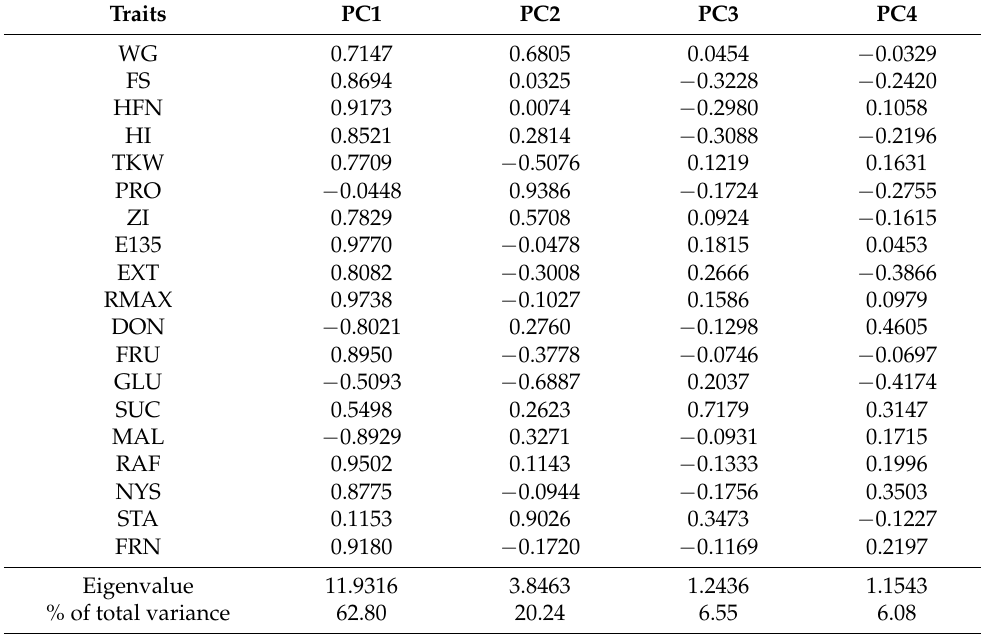
Table 5. Results of PCA analysis: Principal components, eigenvalues, percentage of total variations and factor loads of variables in case of twenty traits of wheat samples. Traits PC1 PC2 PC3 PC4 WG